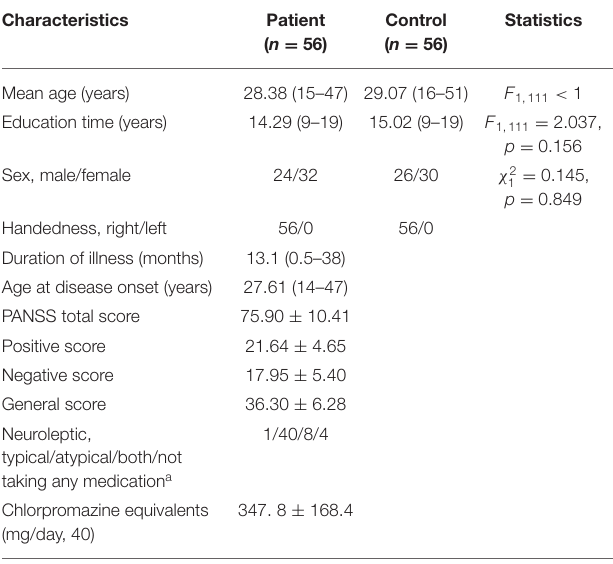
TABLE 1 | Demographic and clinical data for first-episode schizophrenic patient and the control groups.